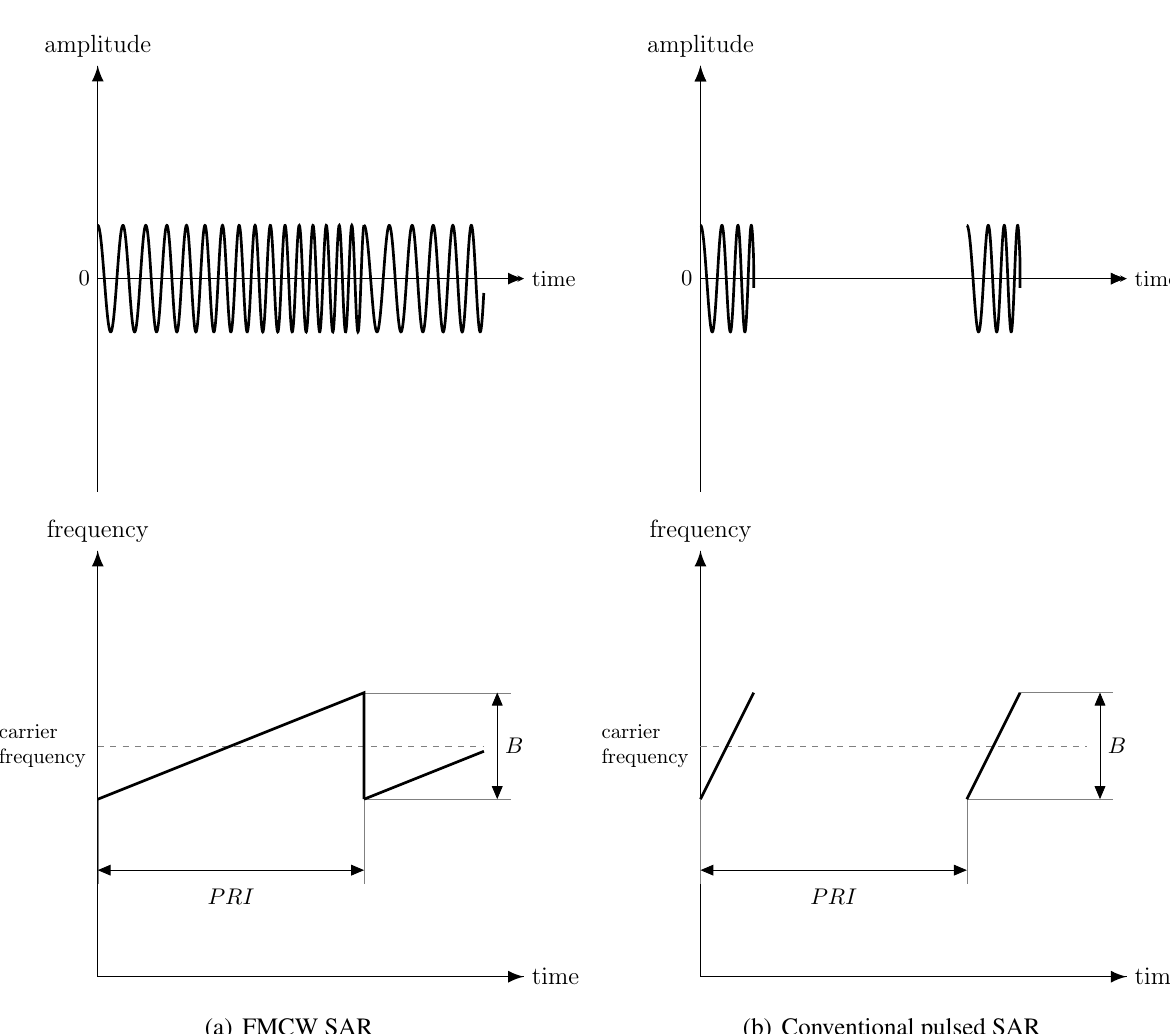
Figure 1. Comparison between pulse repetition interval (PRI) ( a ) in FMCW SAR and ( b ) in conventional pulsed SAR. The lots are not to scale for